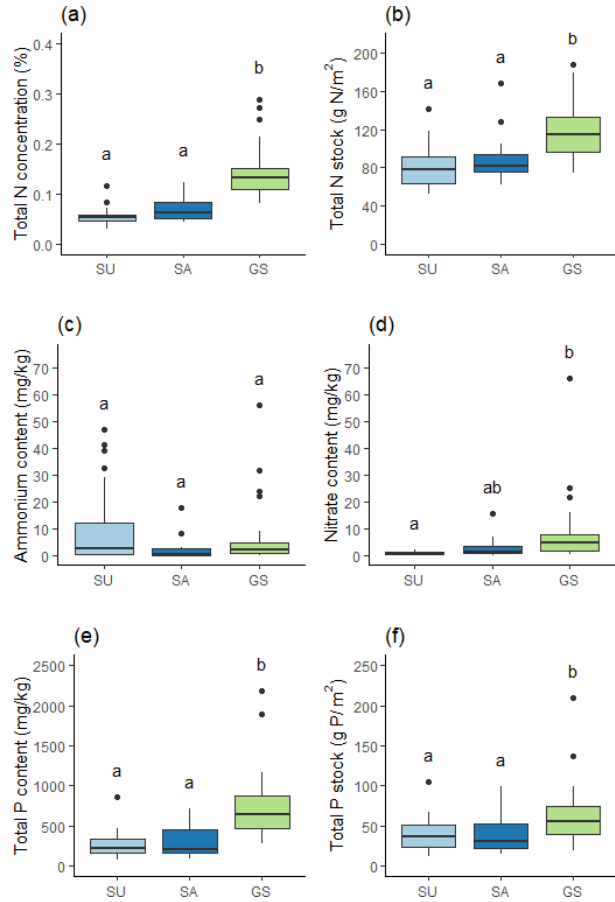
Figure 5. Soil nutrients: (a) total N concentration, (b) total N stock, (c) ammonium content, (d) nitrate content, (e) total P content, and (f) total P stock; these are for SU ( n = 22), SA ( n = 14) and green space (GS; n = 32) soils. Stocks are calculated for the top 10cm of available soil. Different letters indicate a statistically significant difference between soil categories at the 0.05